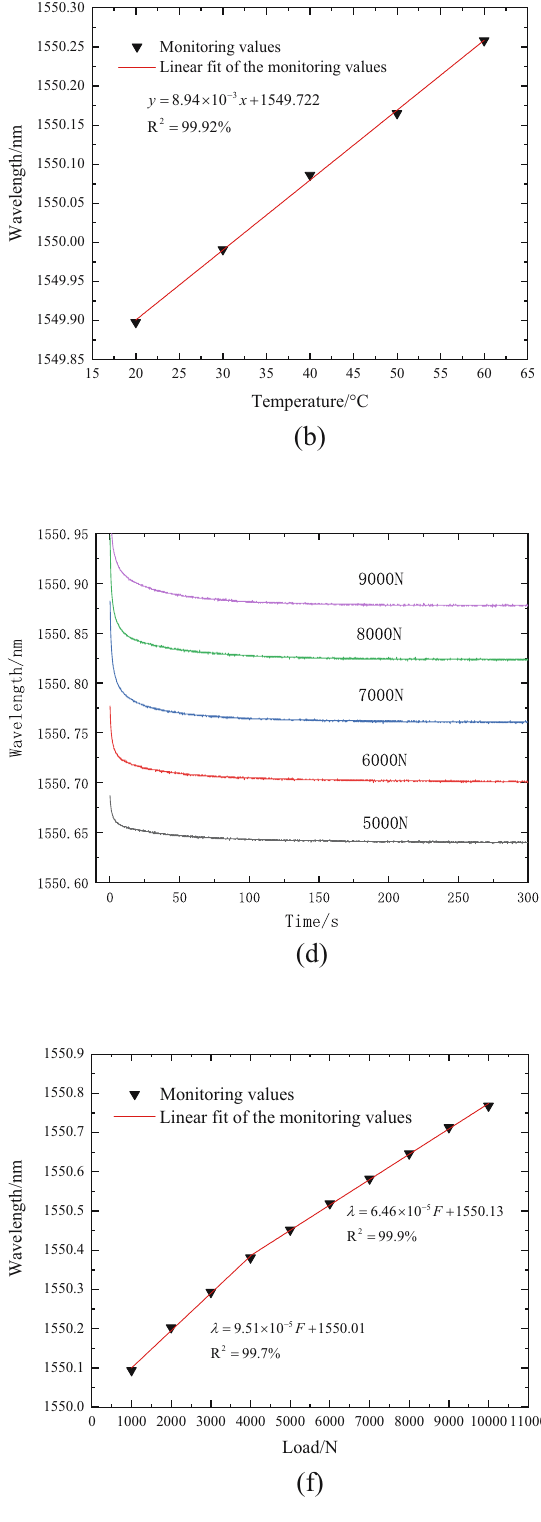
Figure 12: Static load monitoring test results: ( a ) measured values for a 7,000 N static load at di ff erent ambient temperatures, ( b ) measured values for the reference grating at di ff erent ambient temperatures, ( c ) various static load measurements at 30°C, ( d ) magni fi ed image near the measurement zero - point at 30°C, ( e ) measured values for a 7,000 N/0.004 Hz rectangular wave load at 30°C, and ( f ) linear fi tting of various load measurements at